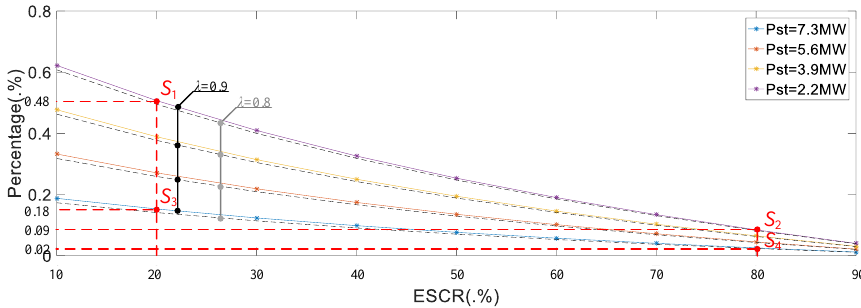
Figure 8. The relation curve of evaluation index of the firm power escalation (EIFPE) with the energy storage power and energy storage conversion rate (ESCR).